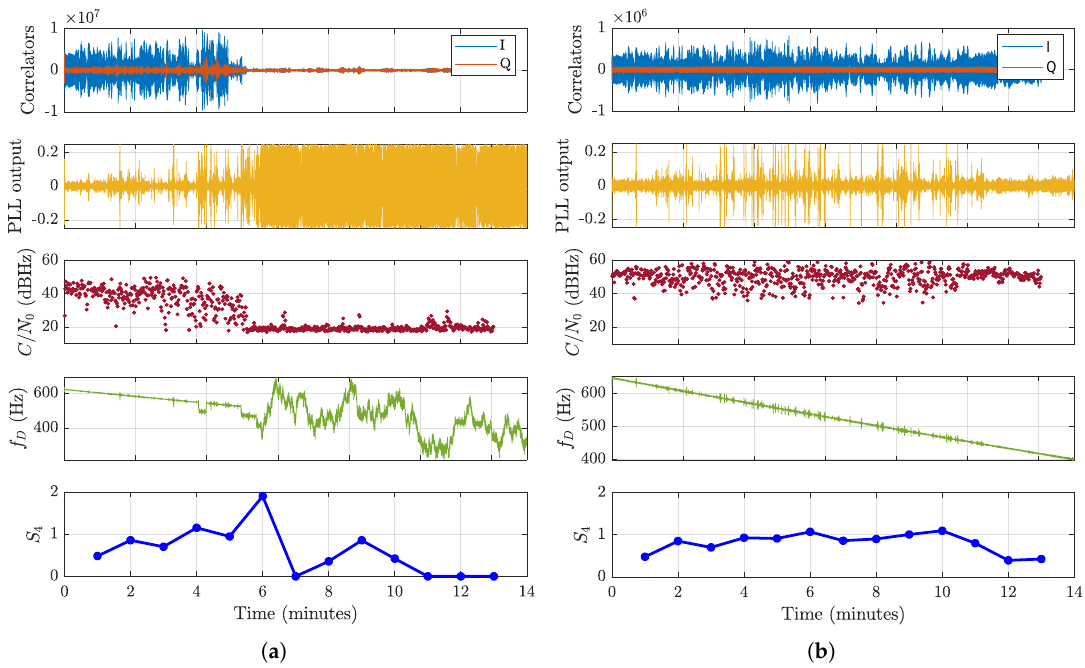
Figure 3. Example of Loss of Lock (LoL) under strong amplitude scintillation in a closed loop receiver; ( a ) second order Phase Lock Loop (PLL) implementation; ( b ) experimental third order